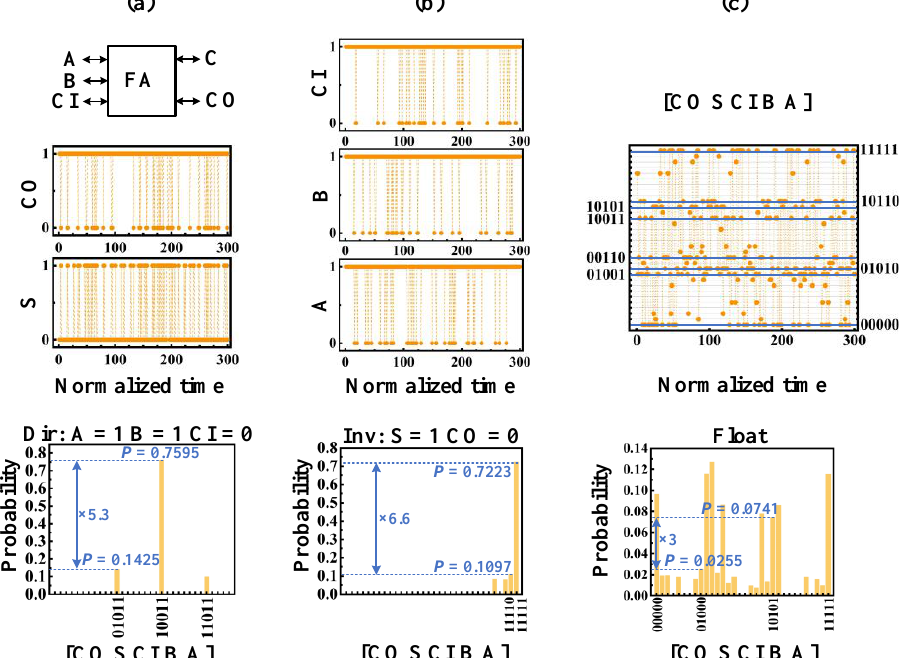
Figure 7. Invertible full adder operation, similar to invertible AND gate including directional mode ( a ), inverse mode ( b ), and floating mode ( c ). mode ( a ), inverse mode ( b ), and floating mode ( c